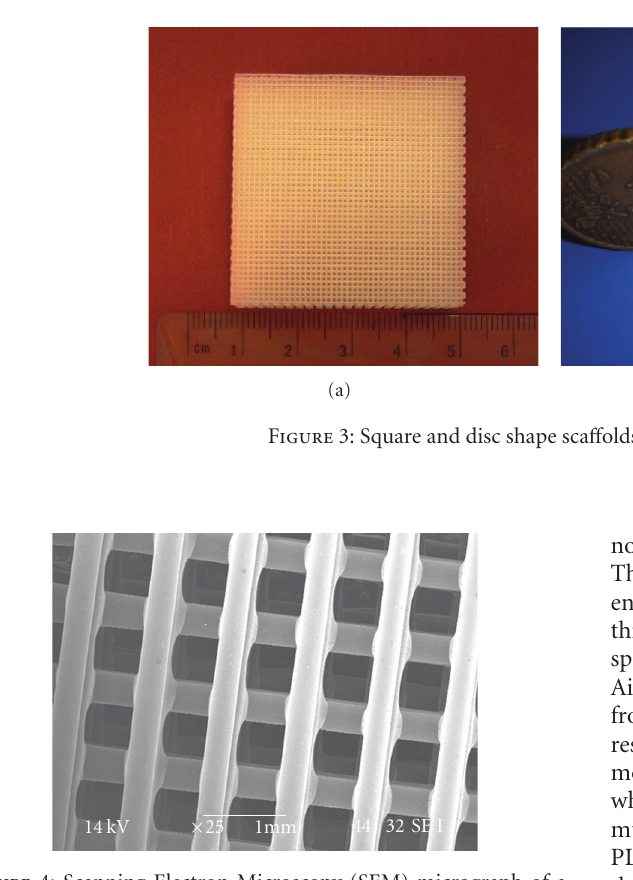
Figure 4: Scanning Electron Microscopy (SEM) micrograph of a sca ff old (top view).